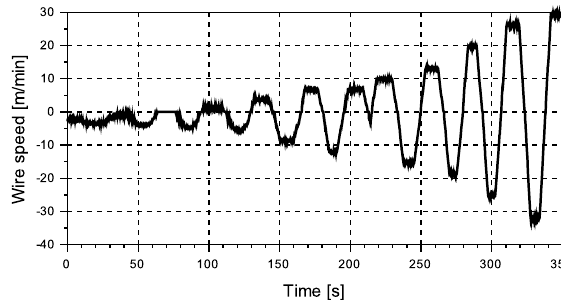
Figure 19: Winch speed profile for the test results shown in Fig. 18